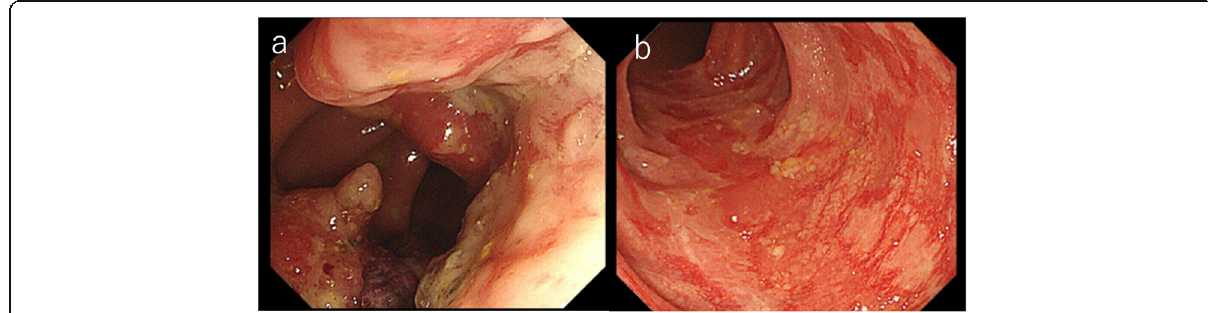
Fig. 1 Colonoscopy revealed a near-circumferential mass at the rectosigmoid colon ( a ). The descending colon on the oral side of the tumor showed reddening and edematous changes circumferentially ( b )